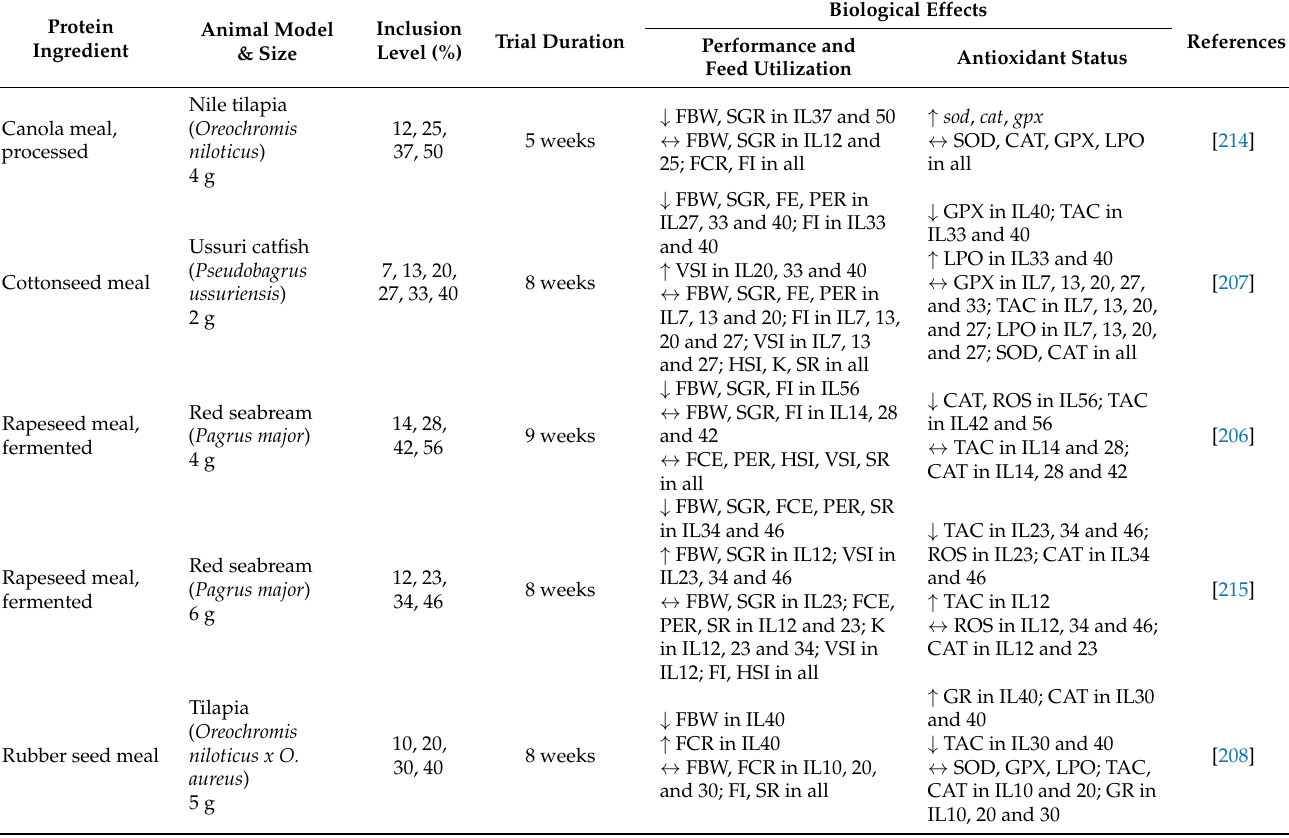
Table 4. Summary of alternative protein and their impacts on fish performance, feed utilization indicators, and oxidative stress